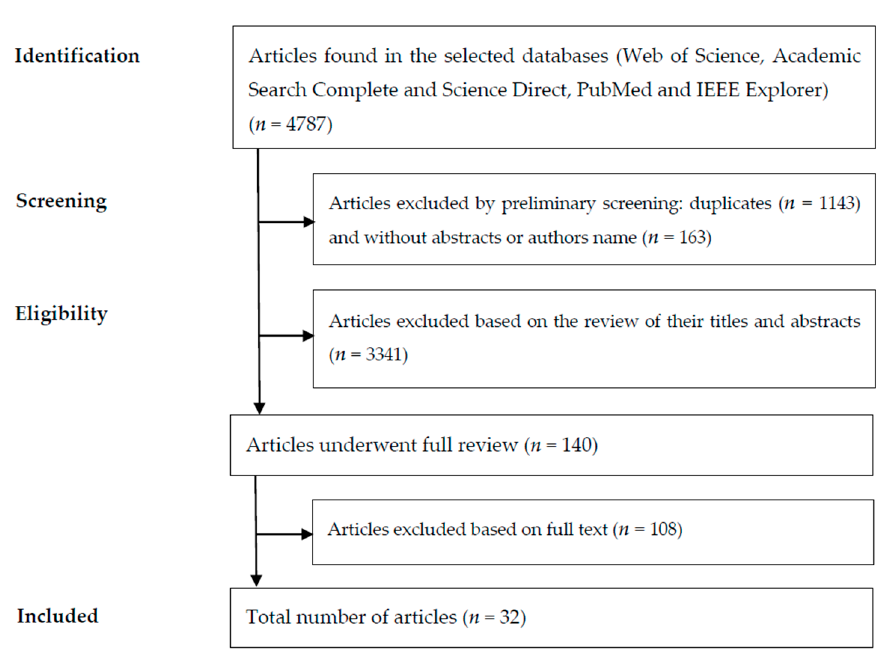
Figure 1. Preferred Reporting Items for Systematic Reviews and Meta-Analyses (PRISMA) Flowchart. Table 2. Classification of articles by